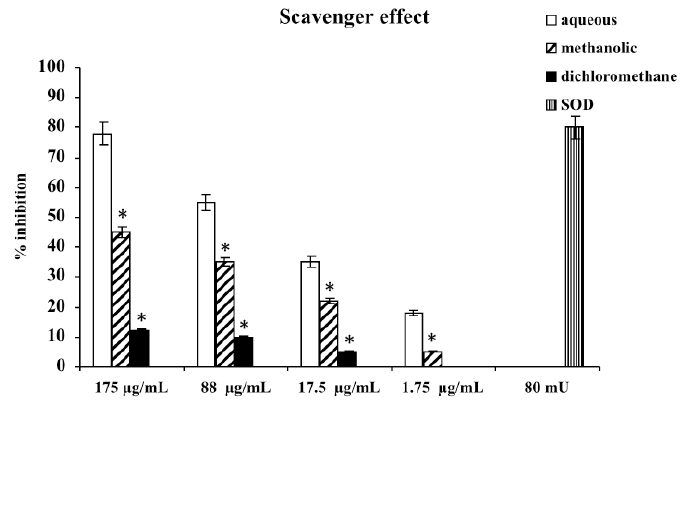
Figure 4. Determination of ROS by DCFH method in cultured hMSC: effect of aqueous extract of M. foetida Schumach. et Thonn . Each value represents the mean ± S.D. of five experimental determinations. * p < 0.001 vs. the same cells cultured in the absence of plant extract (control). Results are expressed as Fluorescence Intensity (F.I.) × 1 × 10 6 /mg